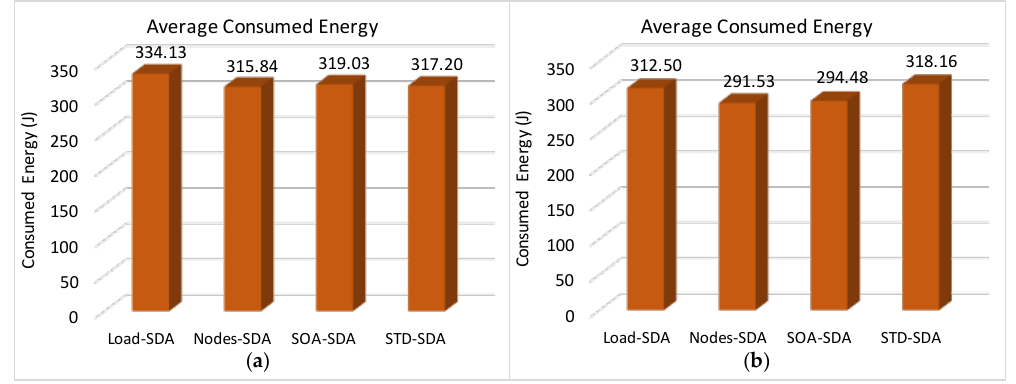
Figure 23. Average consumed energy for the allocation schemes with a shorter beacon interval: ( a ) Unconditioned Scenario; ( b ) Conditioned